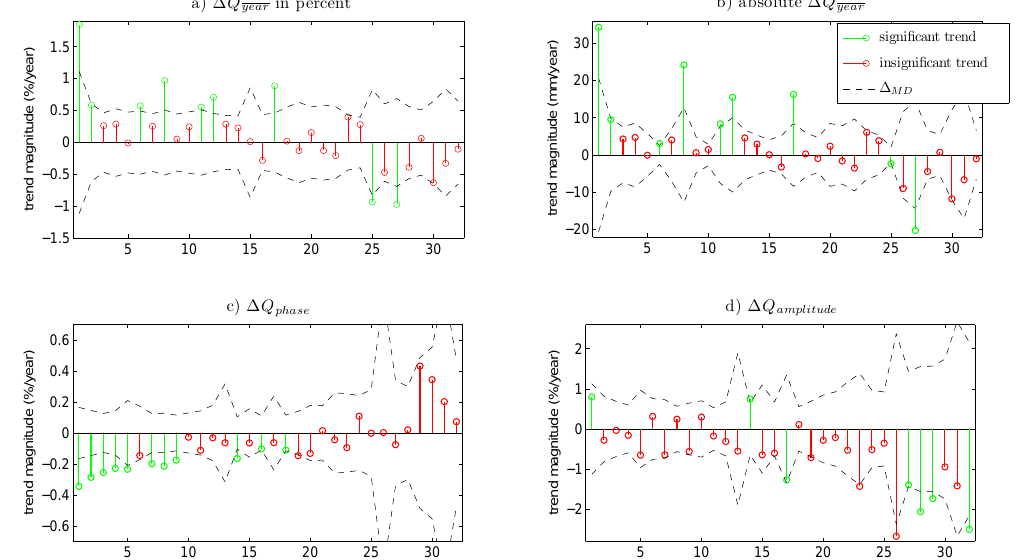
Figure 2. Trend magnitude (percent and absolute values) versus station ID (sorted by rank of mean watershed altitude – 1 = highest).